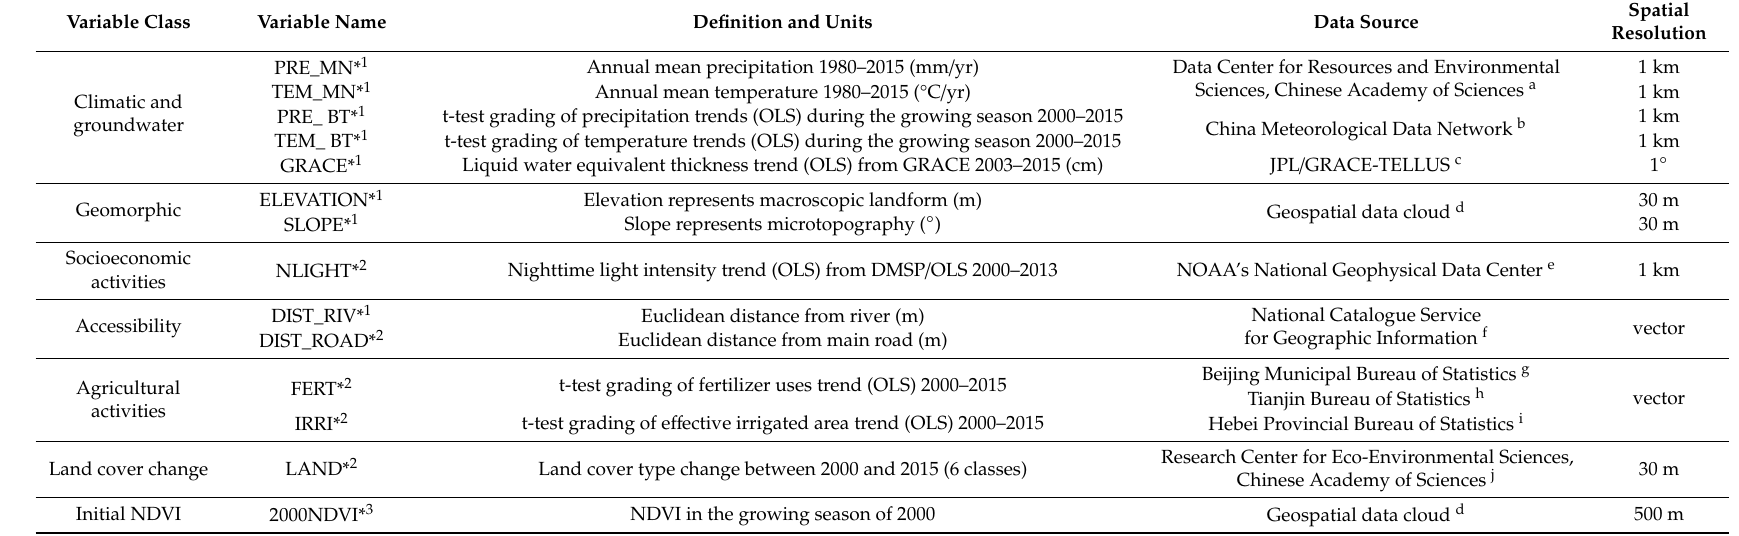
Table 1. Factors used as explanatory variables for NDVI